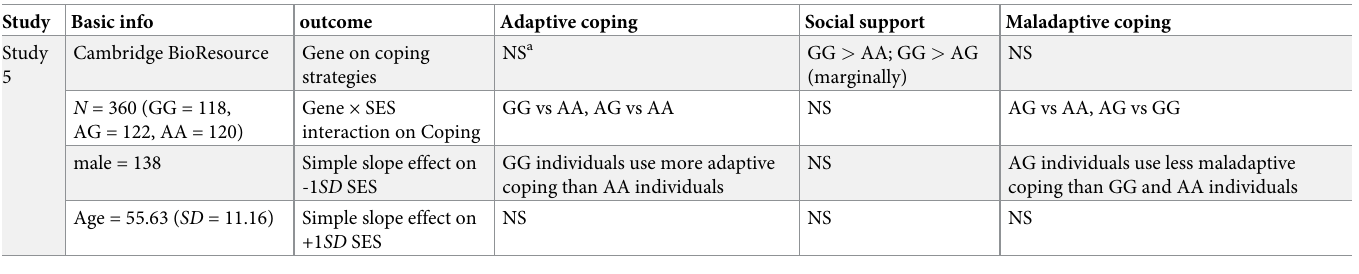
Fig 7. Interaction between genotype and SES on maladaptive coping in Study 5. (A) Line plot. (B) Bar plot with standard deviation. Table 8. Results summary from Study 5.